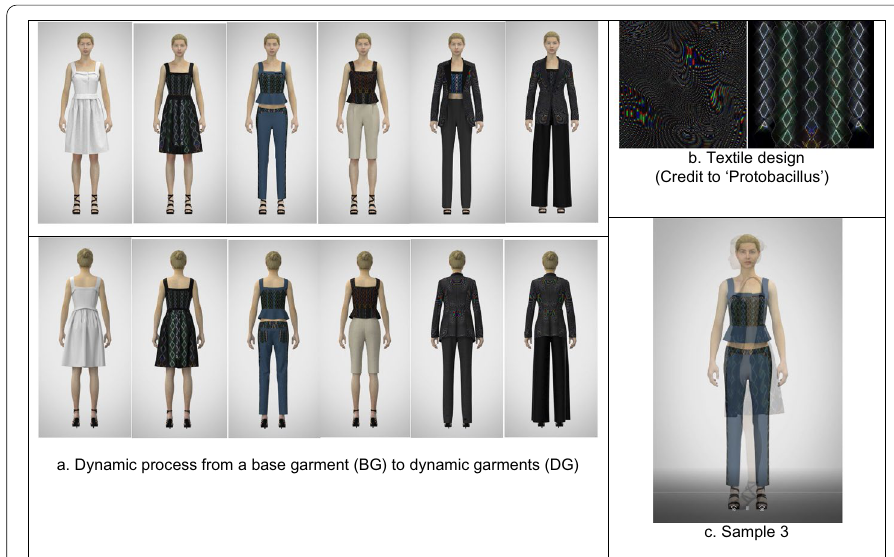
Fig. 3 The technical process to develop a 3D dynamic fashion garment (sample 3): a The moving images, b textile design (GIF), and c sample 3 (MP4) are available in Additional file 1